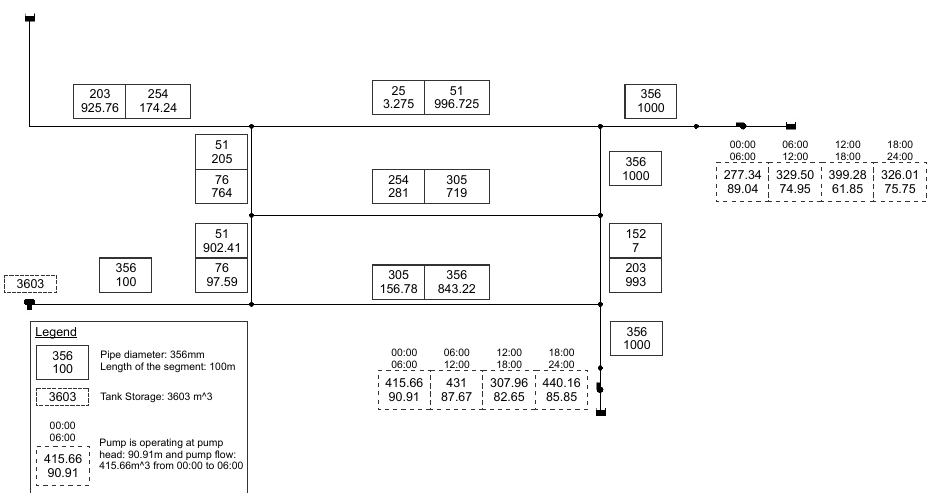
Figure 5. The detailed solution of the two-loop network with four loading conditions using the proposed two-stage LP-NLP